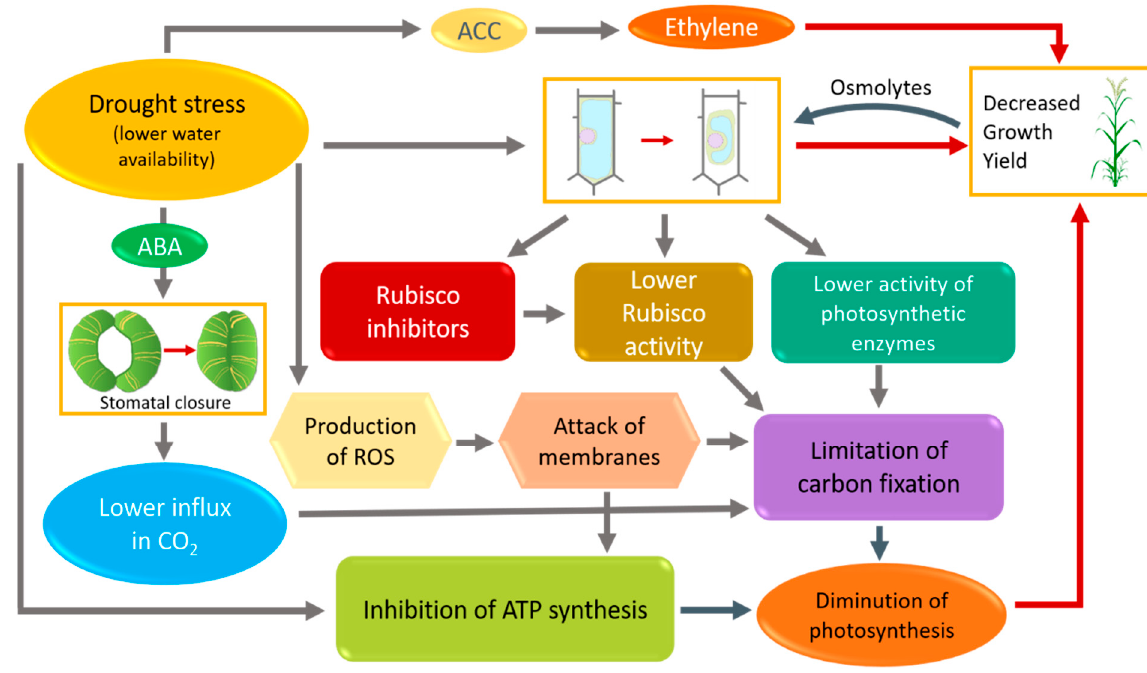
Figure 1. Impact of drought stress on plant photosynthesis, growth and yield (inspired from Farooq et al., 2009). ABA: abscisic acid; ACC: 1-aminocyclopropane-1-carboxylate; ROS: reactive oxygen species.